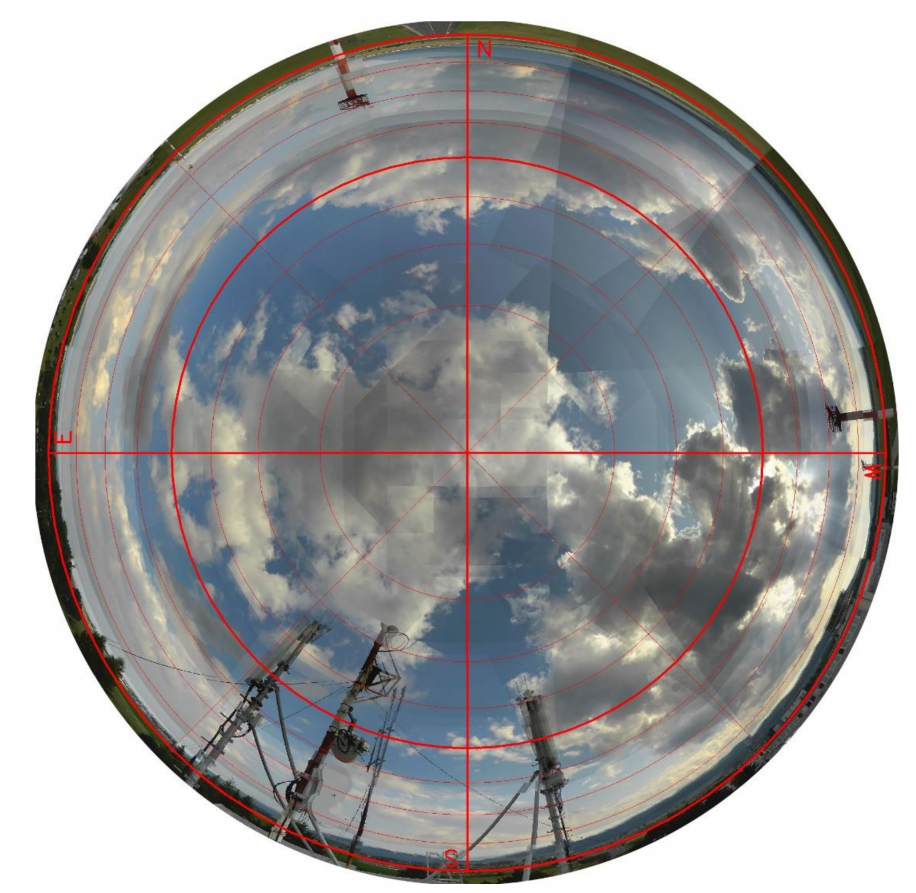
Figure 5. Aiding tools for the assessment of the cloud coverage in the human–machine interface of the proposed